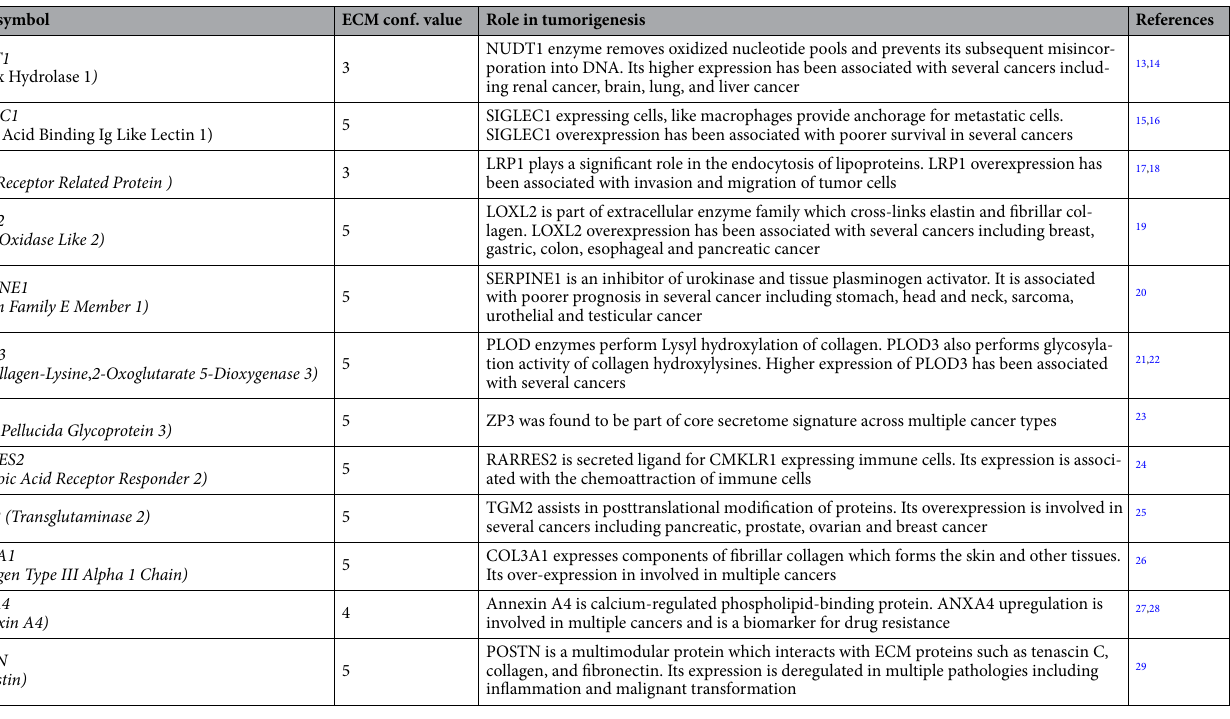
Table 1. Biological role of 12 genes. The ECM confidence value ranged from 0 (absence of any extracellular evidence), 1 (low confidence of extracellular evidence) to 5 (highest confidence of extracellular evidence). Cellular localization of these genes was incorporated from Genecards (https:// www. genec ards.